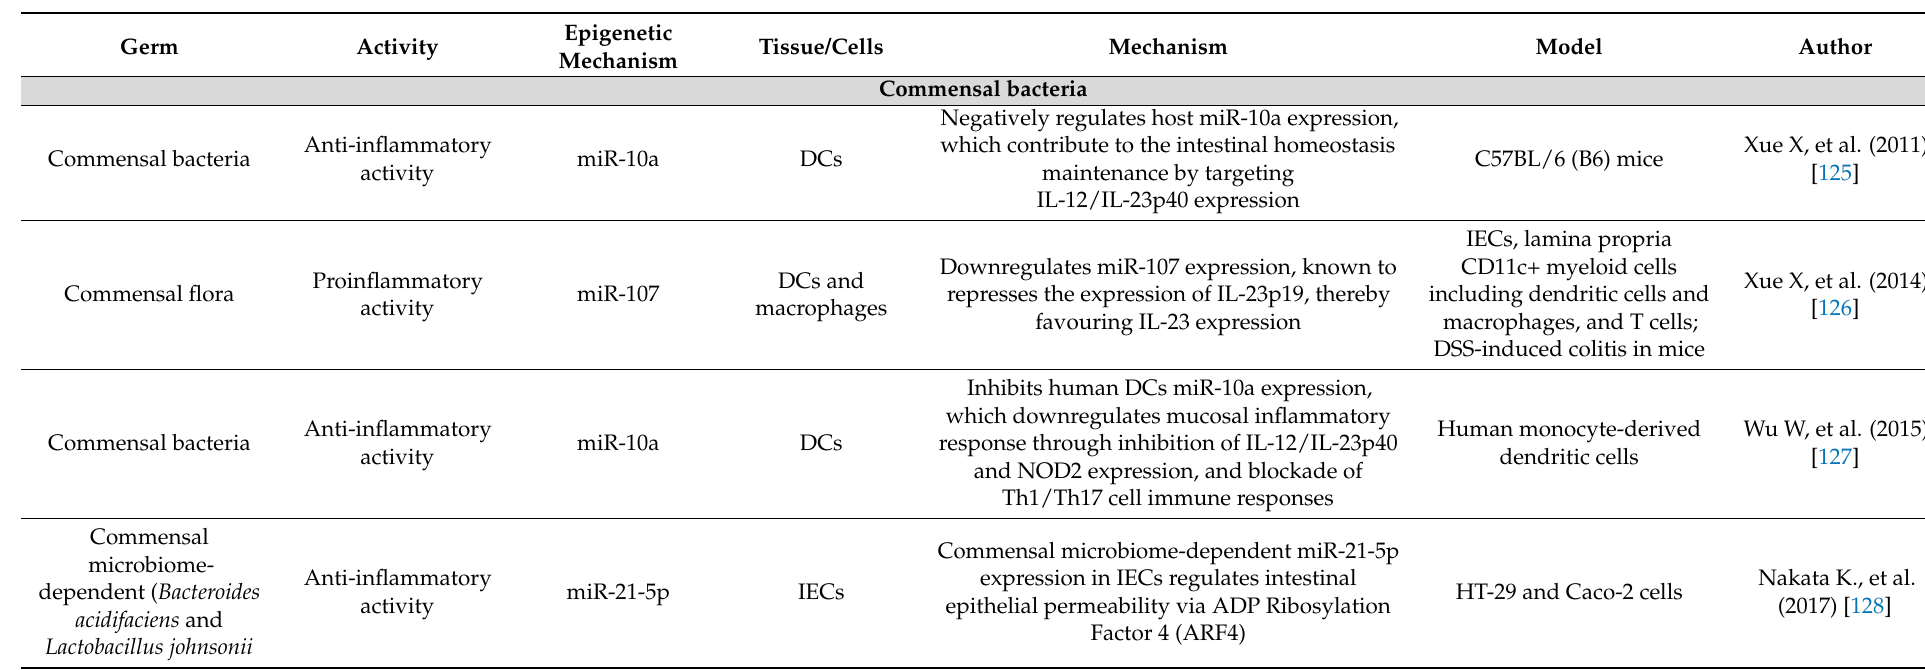
Table 1. Impact of the microbiota on the epigenome in intestinal inflammation . AIEC, adherent-invasive Escherichia coli; CpG, cytosine–phosphate–guanine; DCs, dendritic cells; DNA, deoxyribonucleic acid; DNMT, DNA methyltransferase; DSS, dextran sulfate sodium; ETBF, Enterotoxigenic Bacteroides